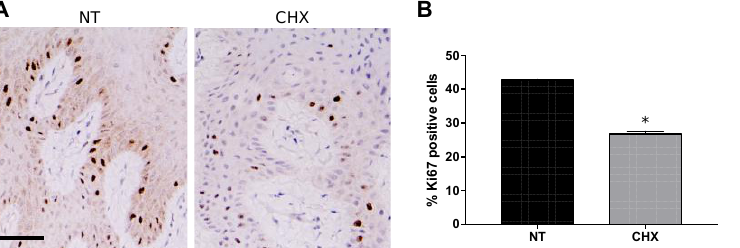
Figure 4. CHX shows an antiproliferative effect in gingival tissues. ( A ) Representative photomicro- graphs of sections of NT and CHX gingival biopsies stained with anti-Ki67 antibodies. Scale bar 50 μm. ( B ) Mean percentage of Ki67 immunopositive cells. * p < 0.05 vs. NT.